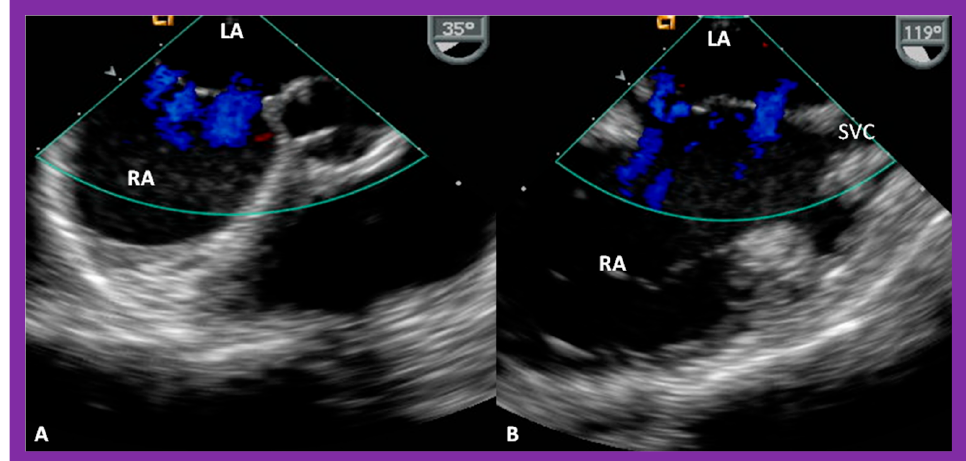
Figure 32. Transesophageal echocardiographic images showing three fenestrations by color Doppler in echocardiographic views ( A , B ) different than shown in Figure 31. LA, left atrium; RA, right atrium; SVC, superior vena cava. Reproduced from Reference [7].